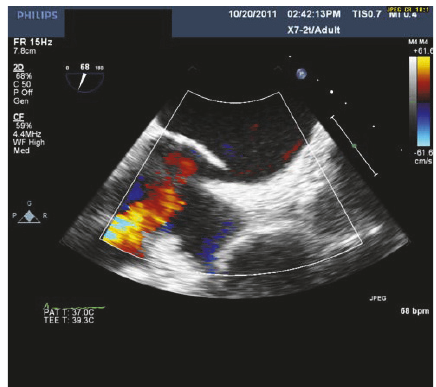
Figure 2: Transesophageal echocardiogram with Doppler demon- stratingright-to-leftinteratrialshuntingthroughthepatentforamen